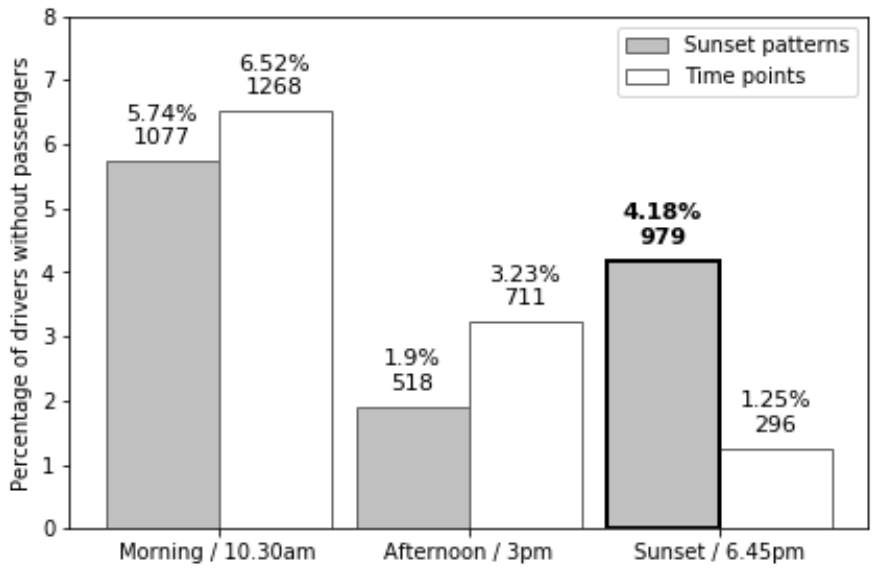
Figure 3: Systematic breaks at sunset and other times. Light bars indicate specific time points; gray bars indicate shifting time points that follow the